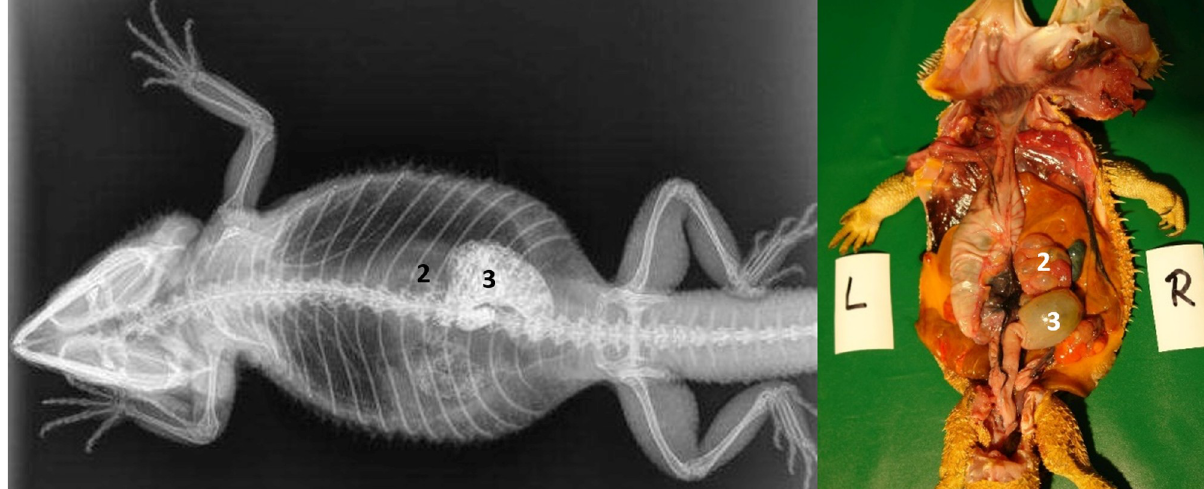
Fig 14. Dorsoventral (DV) radiograph 36 hours after oral administration of BaSO 4 . 36 hours after oral administration of BaSO 4 , (kV 42, mAs 2). Note residual amount of